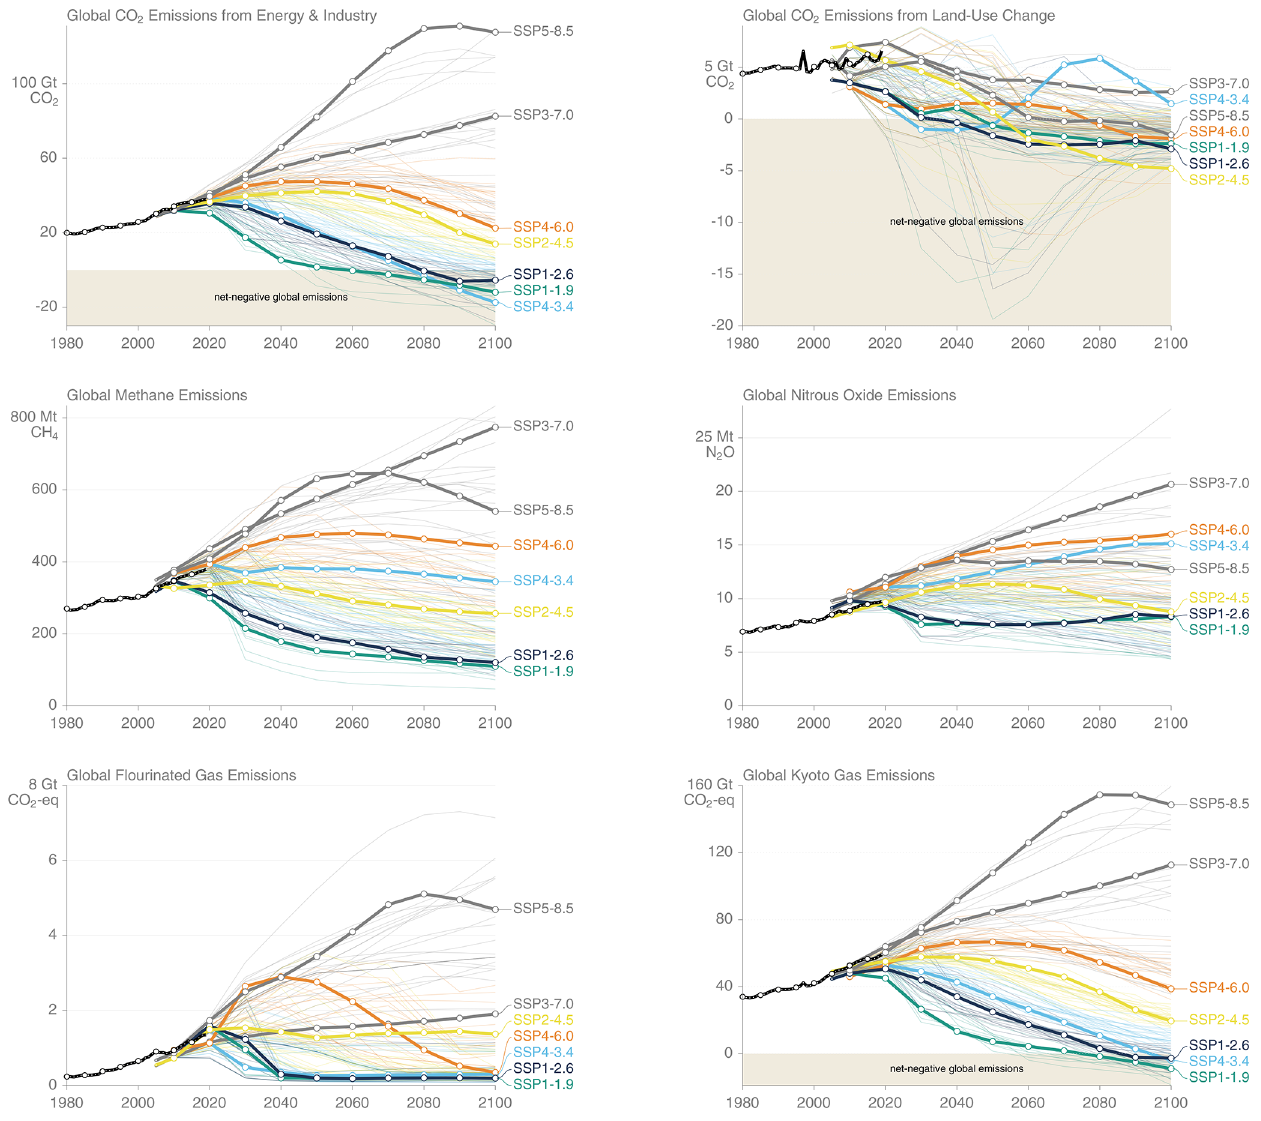
Figure 7. Historical emissions of GHGs and future projections in socio-economic scenarios. The historical emissions are from this dataset. GHG emissions are reported in GtCO 2 eq . converted based on global warming potentials with a 100-year time horizon (GWP-100) from IPCC AR6 (Forster et al., 2021). The Shared Socioeconomic Pathways (SSPs) are from the SSP database version 2 (Riahi et al., 2017; Rogelj et al., 2018). See also https://tntcat.iiasa.ac.at/SspDb/ (last access: 3 November 2021). Highlighted scenarios are the markers used